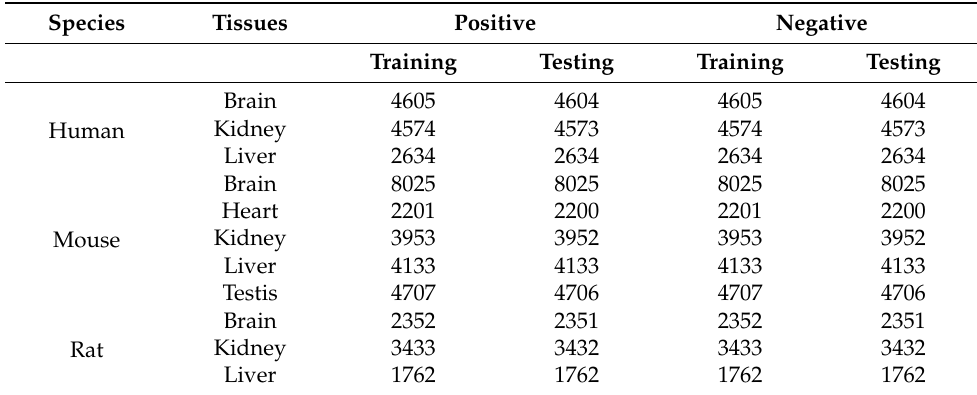
Table 1. The benchmark datasets for RNA m6A sites